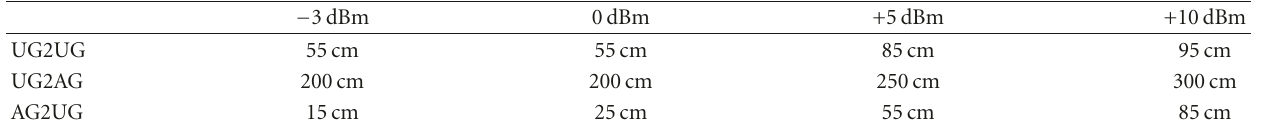
Table 2: Maximum internode distance for PER <